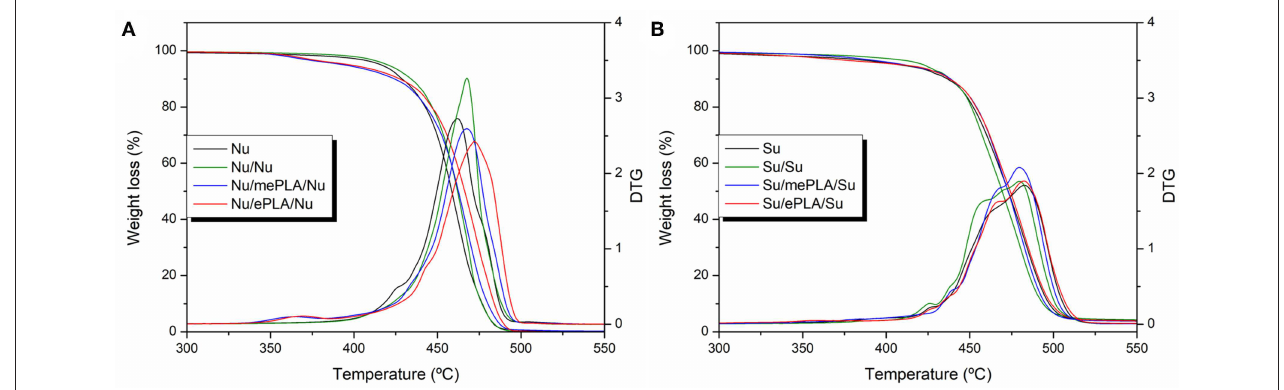
FIGURE 6 | Thermogravimetric analysis of all the processed materials. (A) Nucrel-based materials and (B) Surlyn-based